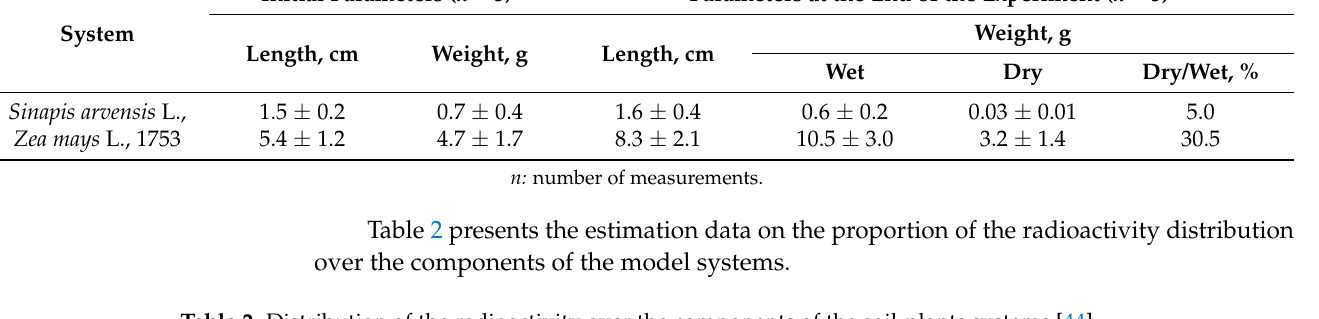
Table 2. Distribution of the radioactivity over the components of the soil-plants systems [44].